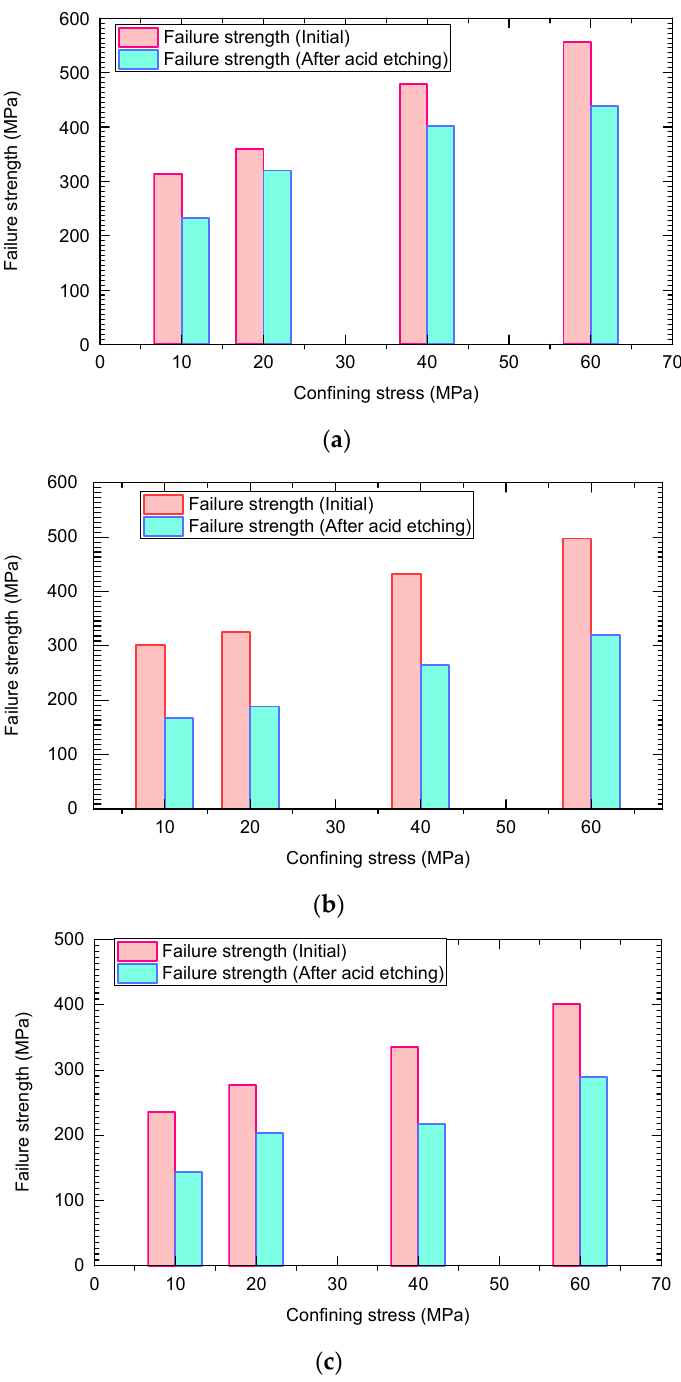
Figure 4. Effect of acid etching on the failure strength of rock samples with different reservoir space: ( a ) Porous, ( b ) Fracture-dissolved pore, ( c ) Fracture-pore.